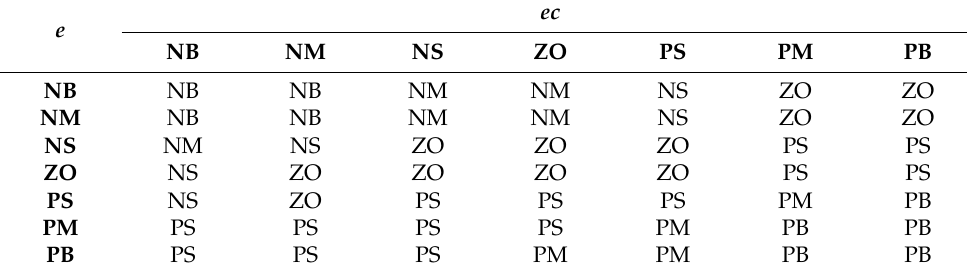
Table 2. Fuzzy control rules of ∆ K i .